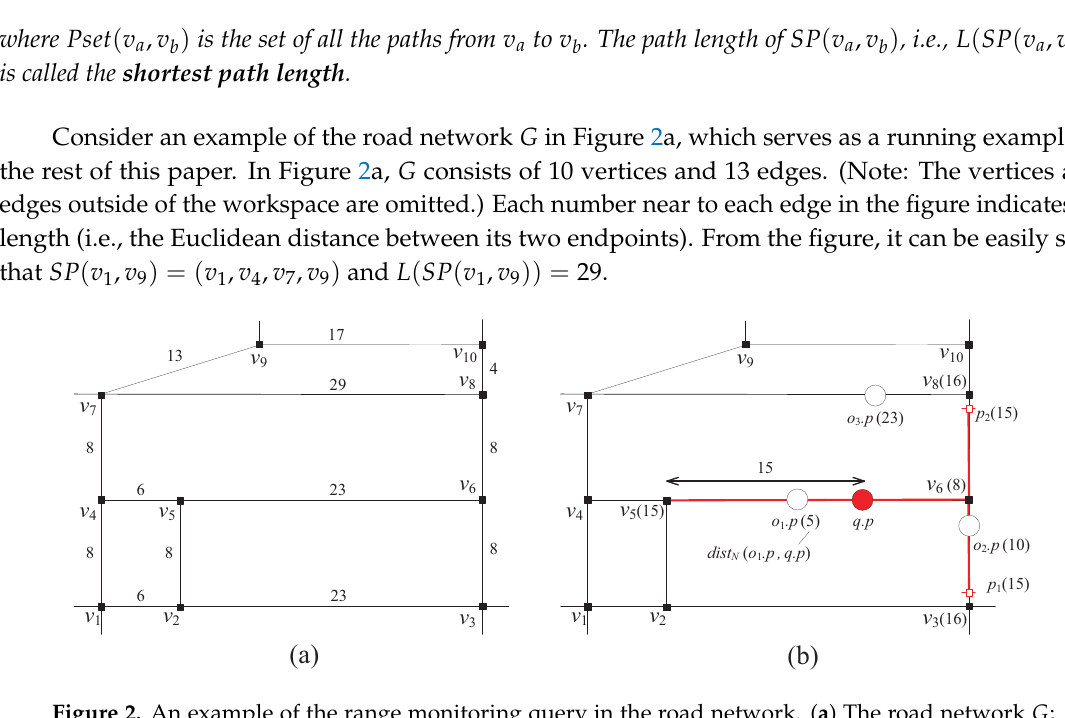
Figure 2. An example of the range monitoring query in the road network. ( a ) The road network G ; ( b ) The range monitoring query in G